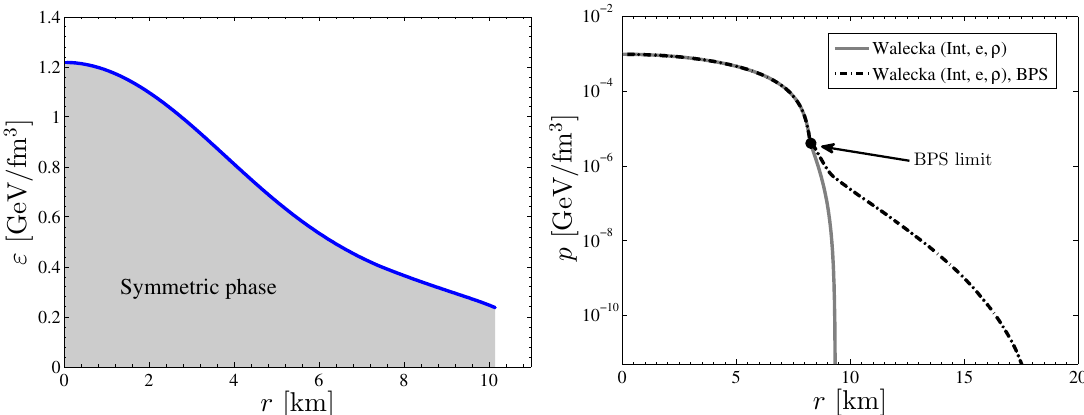
Figure 4. Left panel: The energy density as a function of radial coordinate inside the maximum mass compact star corresponding to the eLSM with g v = 0. The chiral phase transition occurs at the very edge of the star, hence the whole star is basically composed of chirally symmetric quark matter. Right panel: To ilustrate the effect of the BPS EoS in the Walecka model, we show the pressure as a function of the radial distance for a central energy density of ε 0 = 7 · 10 8 MeV 4